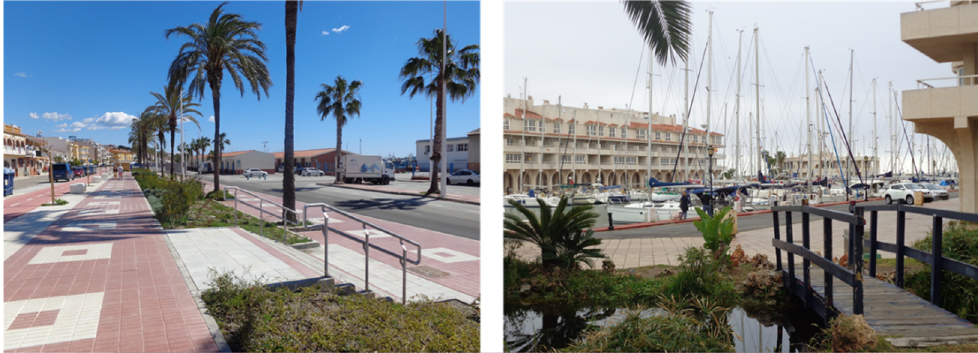
Figure 7. Landscaping in marinas, Caleta de Vélez (Málaga) and Almerimar (Almería), ES. Figure 6. Landscaping in marinas, Caleta de V é lez (M á laga) and Almerimar (Almer í a), ES.